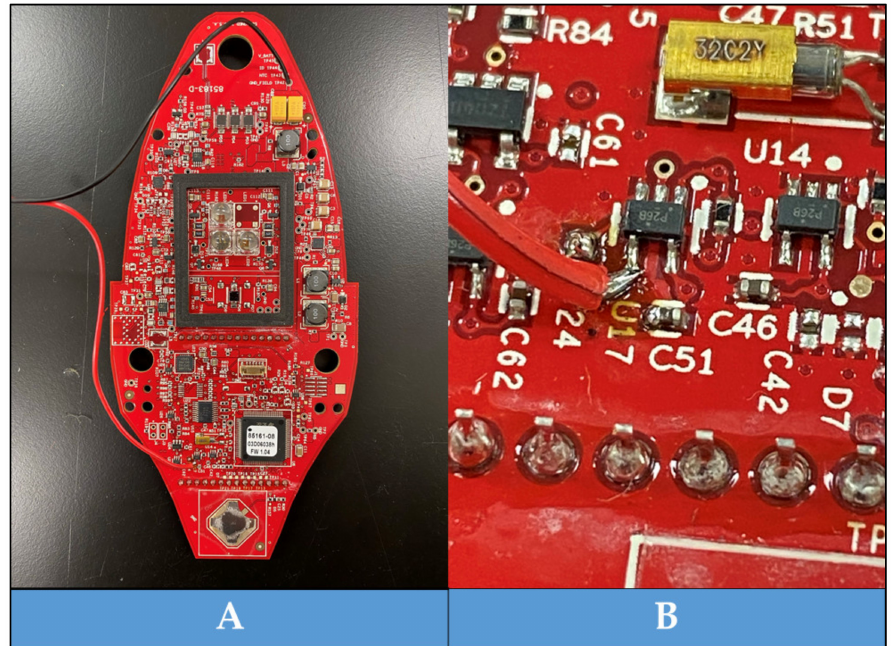
Figure 1. A modified GreenSeeker’s internal circuitry from two perspectives. ( A ) GreenSeeker PCB with leads soldered to the TTL signal lines and ground terminal, ( B ) The Greenseeker’s TTL TX signal lead soldered on the